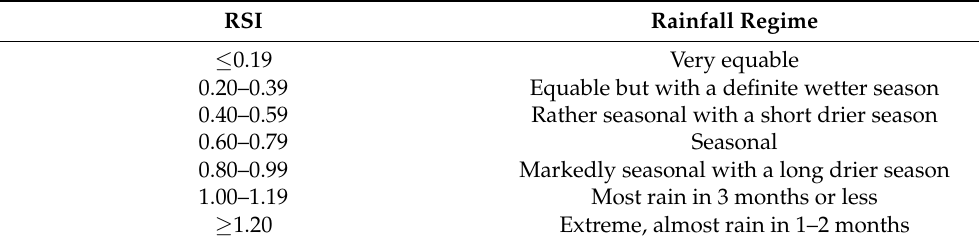
Table 1. The explanation of the centralization of monthly rainfall based on the rainfall seasonality index [36]. RSI Rainfall Regime ≤ 0.19 Very equable 0.20–0.39 Equable but with a definite wetter season 0.40–0.59 0.60–0.79 Seasonal 0.80–0.99 1.00–1.19 Most rain in 3 months or less ≥ 1.20 Extreme, almost rain in 1–2